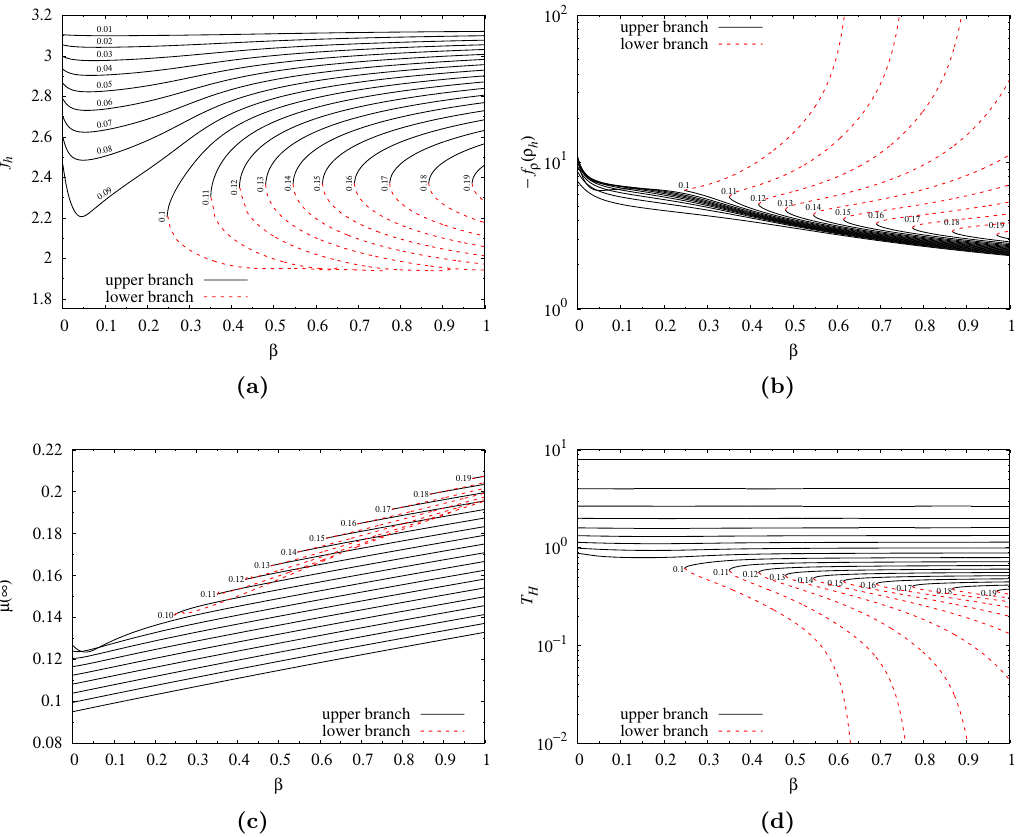
Figure 11 . Upper (black solid lines) and lower (red dashed lines) branches of solutions in the 2 + 4 + 12 model: (a) the value of the pro(cid:12)le function at the horizon, f h ; (b) the derivative of the pro(cid:12)le function at the horizon, f (cid:26) ( (cid:26) h ); (c) the ADM mass, (cid:22) ( 1 ); (d) the Hawking temperature T H ,